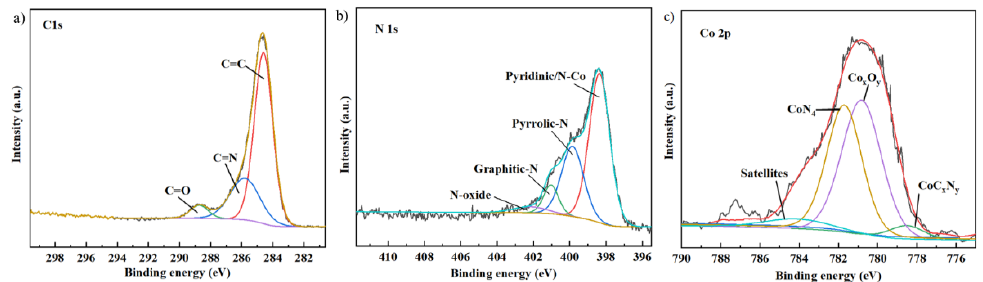
Figure 9. XPS spectra of the catalyst carbonized at the optimum pyrolysis condition ( a ) C1s, ( b ) N1s, ( c ) Co 2p.